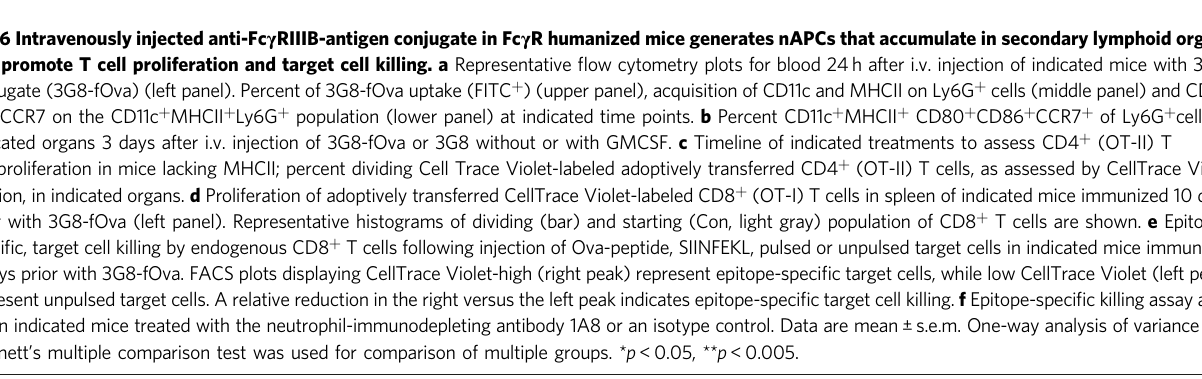
Fig. 6 Intravenously injected anti-Fc γ RIIIB-antigen conjugate in Fc γ R humanized mice generates nAPCs that accumulate in secondary lymphoid organs and promote T cell proliferation and target cell killing. a Representative fl ow cytometry plots for blood 24h after i.v. injection of indicated mice with 3G8- conjugate (3G8-fOva) (left panel). Percent of 3G8-fOva uptake (FITC + ) (upper panel), acquisition of CD11c and MHCII on Ly6G + cells (middle panel) and CD80 and CCR7 on the CD11c + MHCII + Ly6G + population (lower panel) at indicated time points. b Percent CD11c + MHCII + CD80 + CD86 + CCR7 + of Ly6G + cells in indicated organs 3 days after i.v. injection of 3G8-fOva or 3G8 without or with GMCSF. c Timeline of indicated treatments to assess CD4 + (OT-II) T cell proliferation in mice lacking MHCII; percent dividing Cell Trace Violet-labeled adoptively transferred CD4 + (OT-II) T cells, as assessed by CellTrace Violet dilution, in indicated organs. d Proliferation of adoptively transferred CellTrace Violet-labeled CD8 + (OT-I) T cells in spleen of indicated mice immunized 10 days prior with 3G8-fOva (left panel). Representative histograms of dividing (bar) and starting (Con, light gray) population of CD8 + T cells are shown. e Epitope- speci fi c, target cell killing by endogenous CD8 + T cells following injection of Ova-peptide, SIINFEKL, pulsed or unpulsed target cells in indicated mice immunized 7 days prior with 3G8-fOva. FACS plots displaying CellTrace Violet-high (right peak) represent epitope-speci fi c target cells, while low CellTrace Violet (left peak) represent unpulsed target cells. A relative reduction in the right versus the left peak indicates epitope-speci fi c target cell killing. f Epitope-speci fi c killing assay as in ( e ) in indicated mice treated with the neutrophil-immunodepleting antibody 1A8 or an isotype control. Data are mean±s.e.m. One-way analysis of variance and Dunnett ’ s multiple comparison test was used for comparison of multiple groups. * p <0.05, ** p